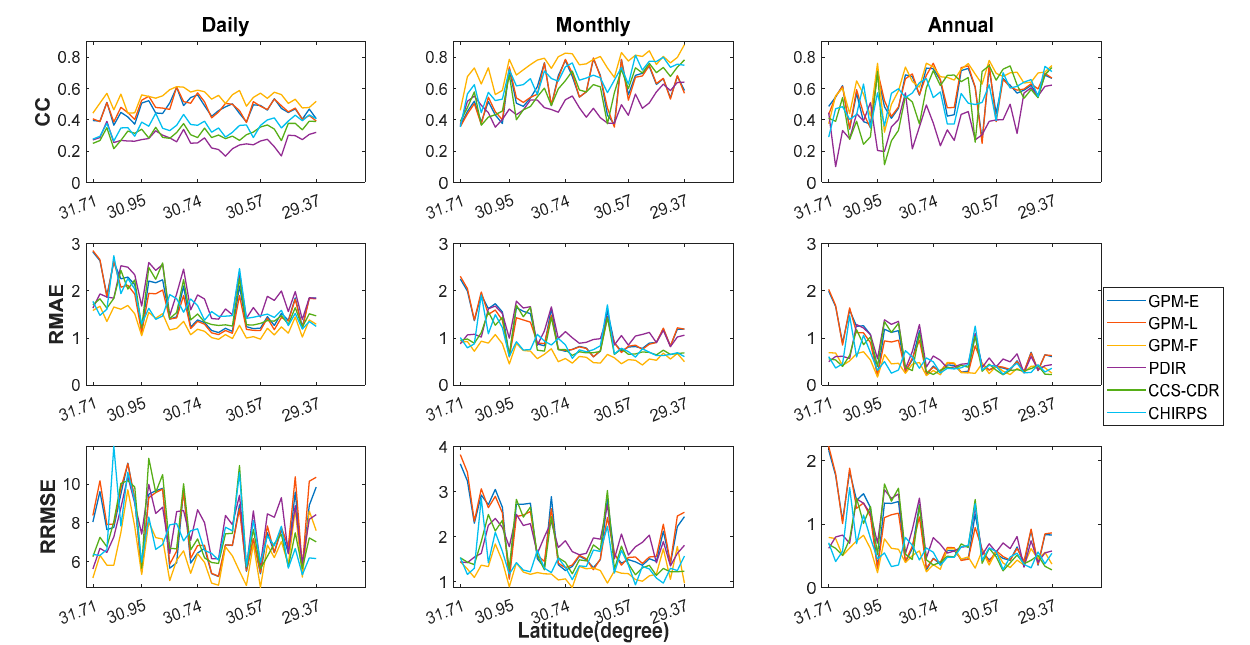
Figure 7. Continuous metrics according to the rain-gauge latitudes for the daily, monthly and annual scales.